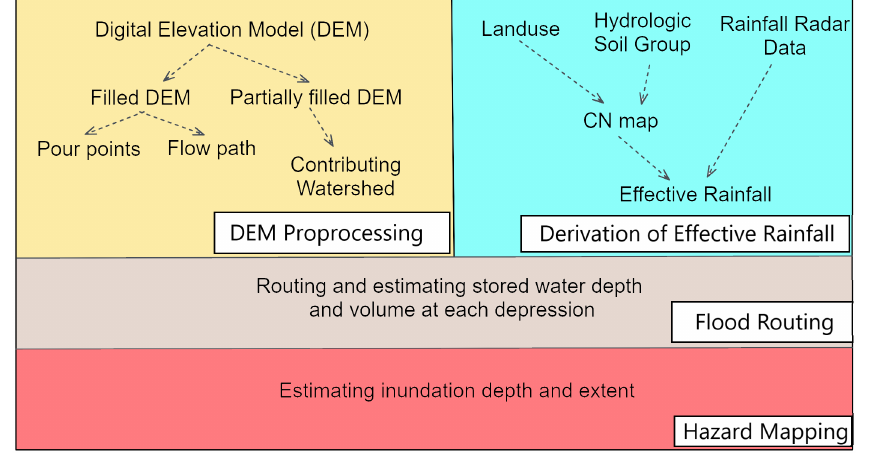
Figure 3. FSM method’s